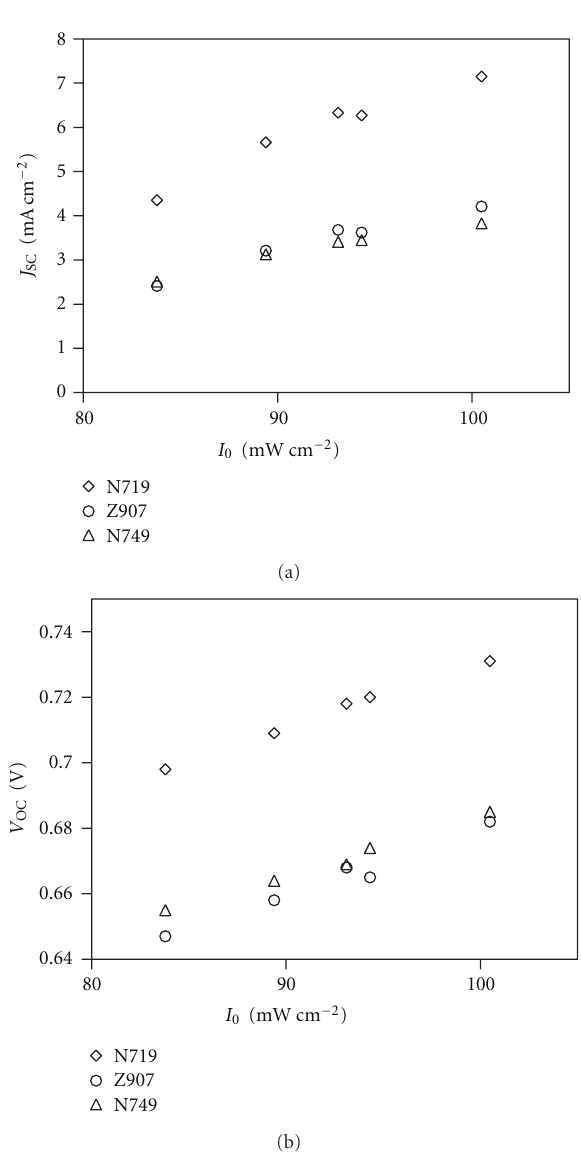
Figure 5: Reduction to (a) J SC and (b) V OC as a result of filtering reducing incident photon flux.